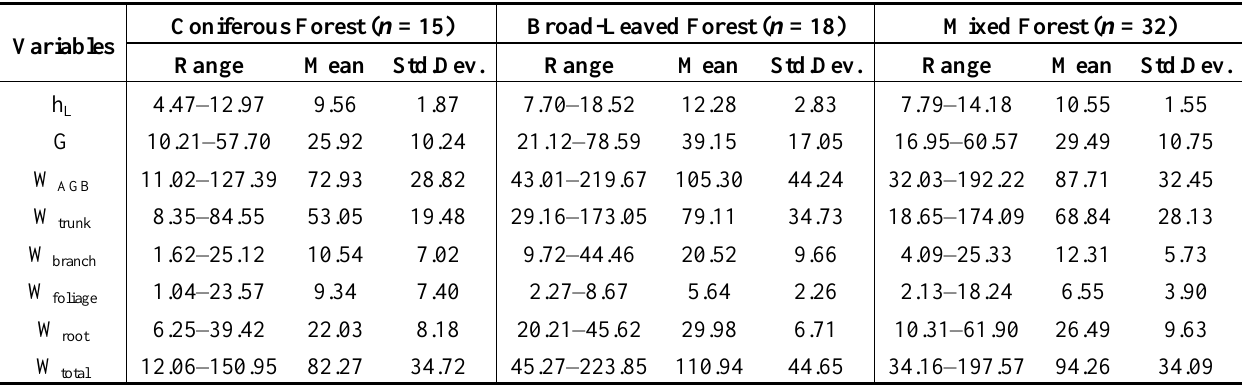
Table 1. Summary statistics of field measured biomass and biomass components in the study area ( n = 65